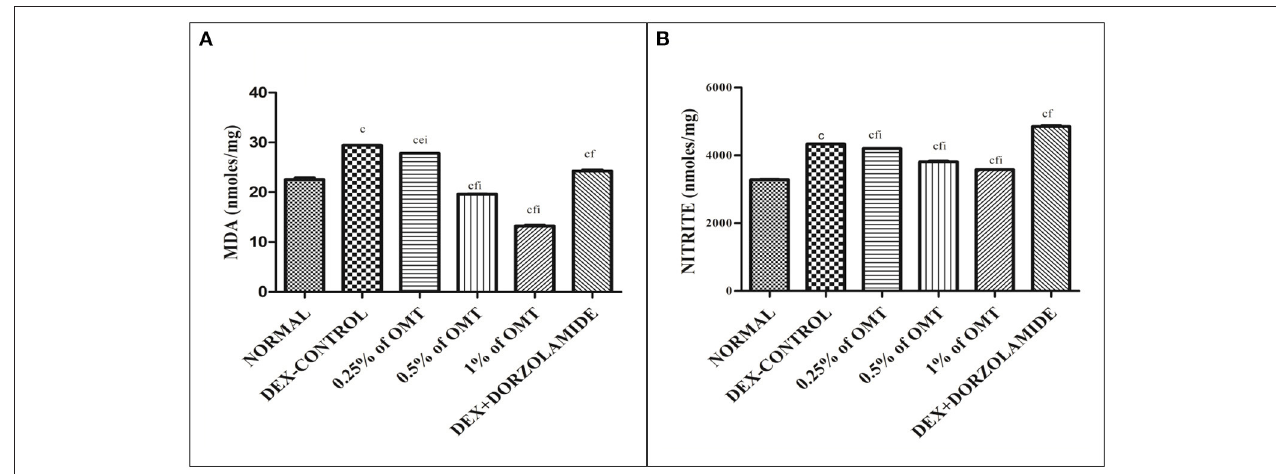
FIGURE 3 | Effects of various treatments on lipid peroxidation and nitrite content in the retinal extracts: (A) MDA and (B) nitrite. Values are expressed as mean ± SEM ( n = 6). Data were analyzed by one-way ANOVA and are expressed as a p < 0.05, b p < 0.01, c p < 0.001 when compared to normal group, d p < 0.05, e p < 0.01, f p < 0.001 when compared to DEX-induced glaucoma control group, and g p < 0.05, h p < 0.01, i p < 0.001 when compared to standard group, respectively. Normal: 100 µ l of distilled water; control: 0.1ml of 0.1% DEX solution; treatment 1: 50 µ l of 0.25% OMT solution; treatment 2: 50 µ l of 0.5% OMT solution; treatment 3: 50 µ l of 1% OMT solution; standard: 100 µ l of 1% of dorzolamide